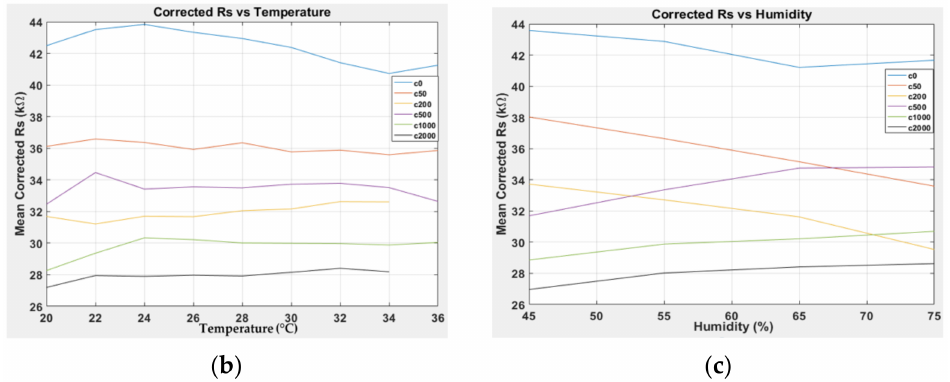
Figure 13. ( a ) Three-dimensional surface graph of GM-402B corrected R S using m5 model at varying temperature and humidity levels and different ethanol solution concentrations, ( b ) mean of corrected R S versus temperature, and ( c ) mean of corrected R S versus humidity.